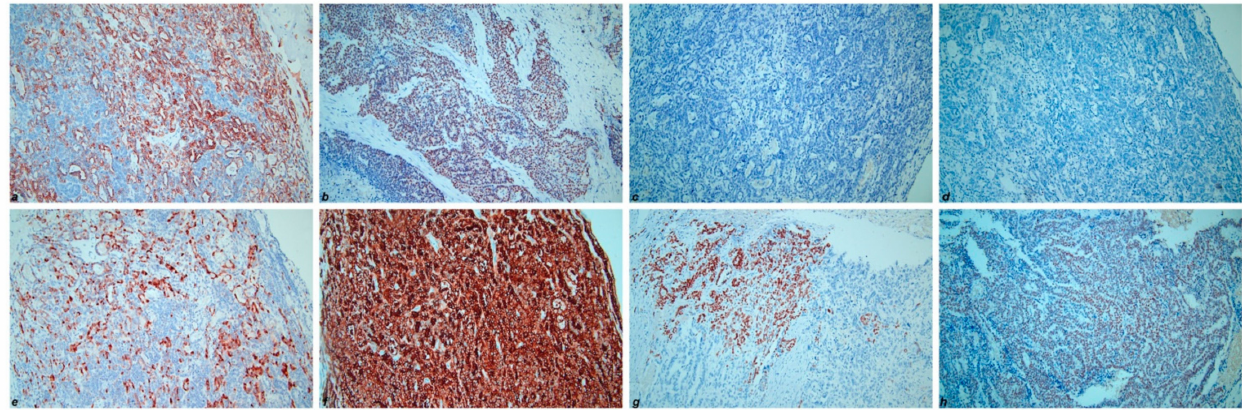
Figure 5. Immunohistochemical results of mesonephric-like adenocarcinoma component: ( a ) CK7; ( b ) PAX8; ( c ) ER; ( d ) PR; ( e ) Calretinin; ( f ) CD10; ( g ) TTF-1; ( h ) GATA-3. (200 ×